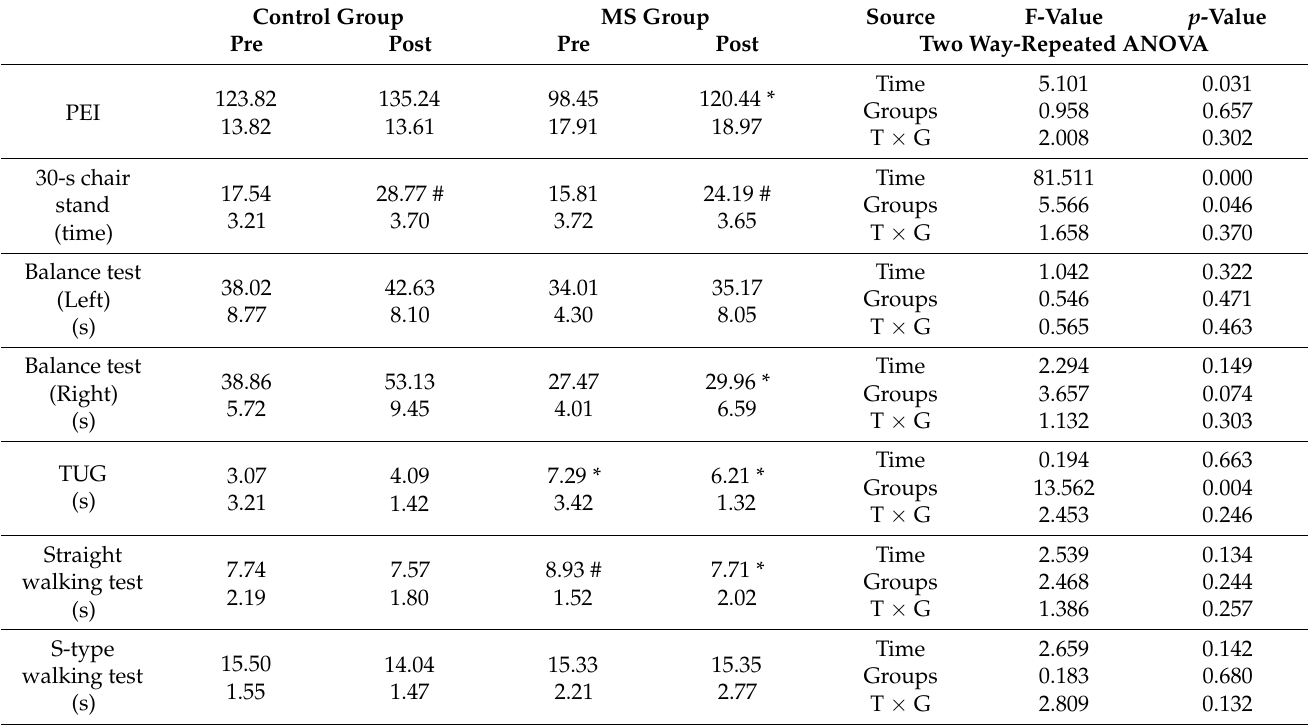
Table 5. Change of physical fitness after exercise